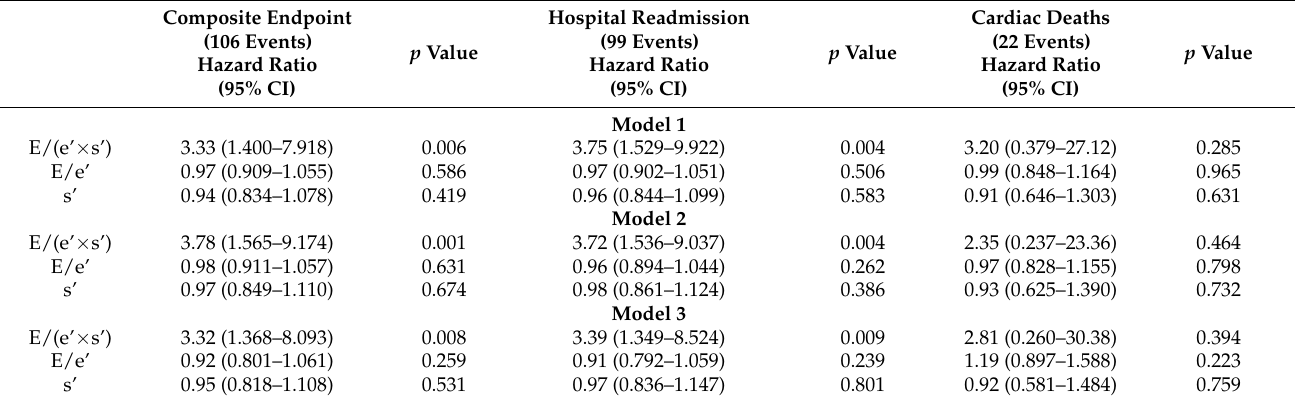
Table 3. Multivariable Cox regression associated with cardiac events, hospital readmission, and cardiac